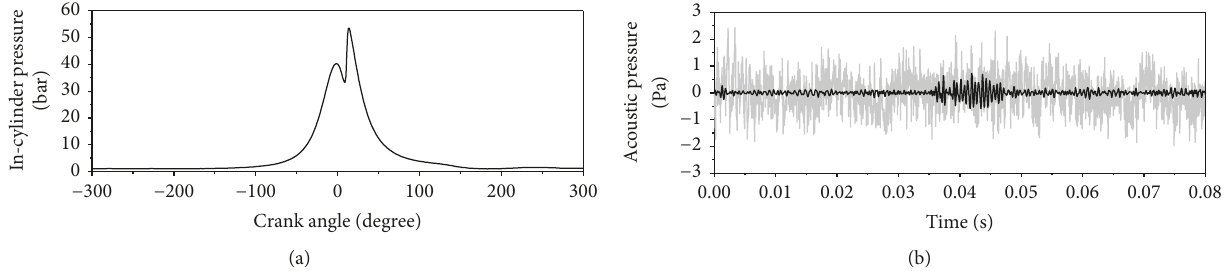
Figure 3: Comparison between (a) in-cylinder static pressure and (b) acoustic pressure for a single-cylinder diesel engine. For the acoustic pressure, the gray and black lines show measured and filtered (from 1.1 to 2.9 kHz and 1.9 to 2.1 kHz) acoustic pressures to minimize influence from the dynamometer used in the